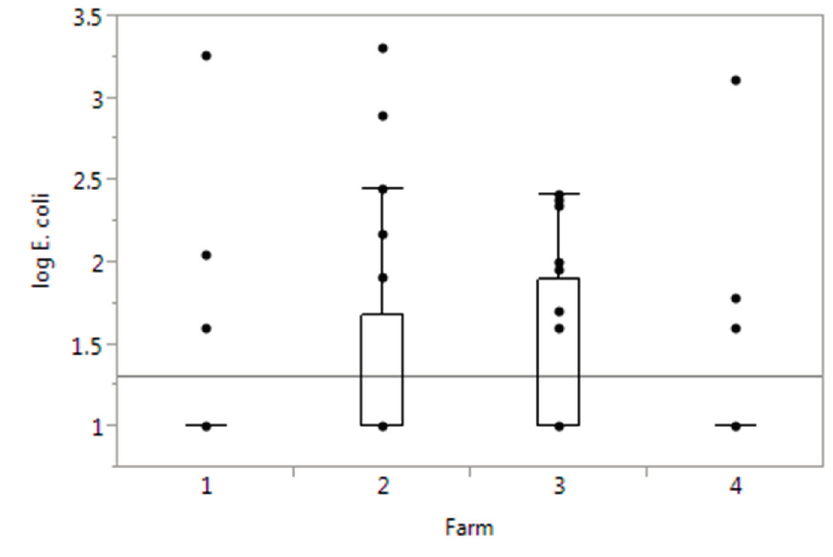
Figure 3. Boxplots of E. coli counts (log 10 cfu/g) in soil by farms. The horizontal line shows the overall mean